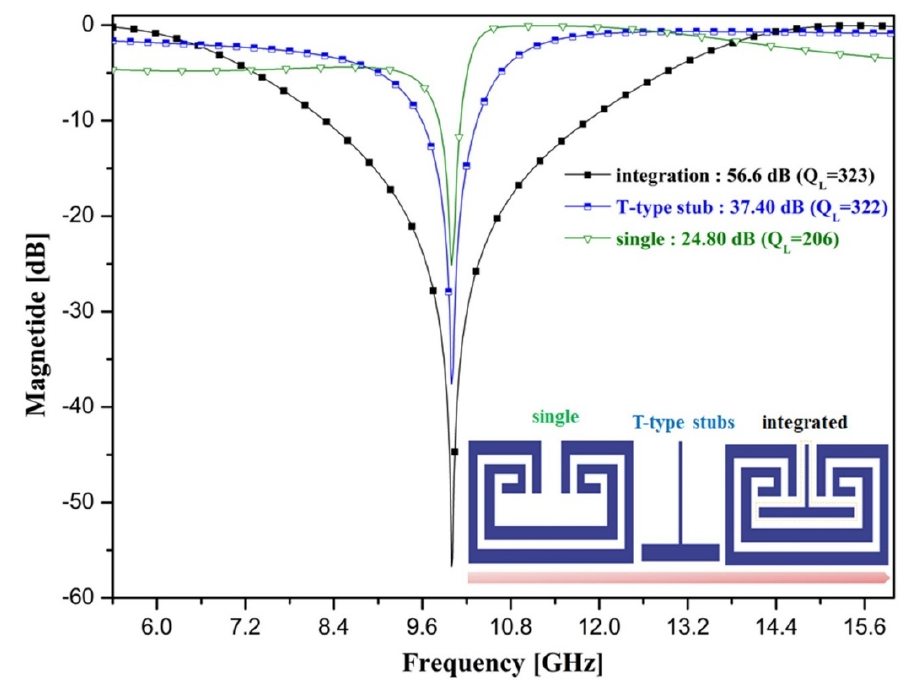
Figure 4. Q L change process in the resonator design stage.